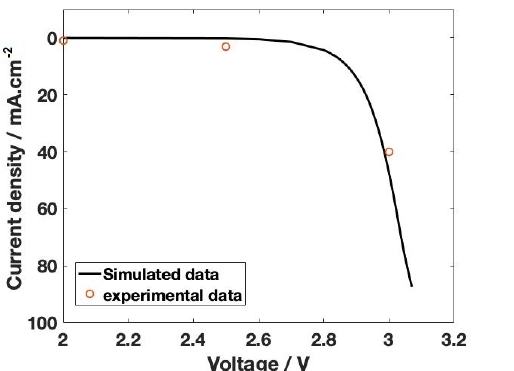
Figure 11. The polarization curve of CO 2 electrolyzer at 5 bar. The curve is generated by combining equilibrium potential ( E equ ) and activation overpotential of respective electrode reactions (cathode and anode) and the membrane. The value for E equ is assumed from the onset voltage of the polar- ization curve obtained from experimental data. The mass transport resistance of CO 2 is included in calculating the total current density, which is the sum of partial current density of formate/formic acid, CO and H 2 . The ohmic loss is not included in the polarization curve, and it can be added as a series resistance to calculate the current density. The black bold line is the simulated polarization curve, and the hollow circles are experimental data